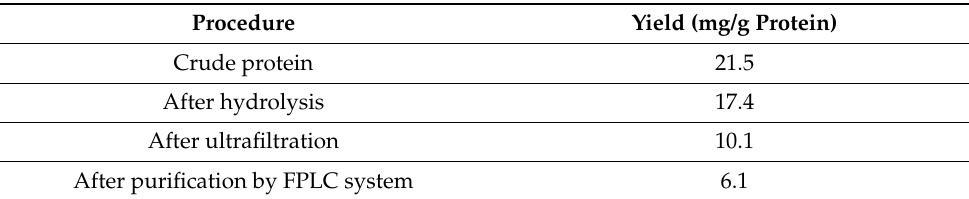
Figure 2. Elution of the HiTrap Q XL column (1 mL) (GE Healthcare). Table 2. Yield of chickpea peptide.